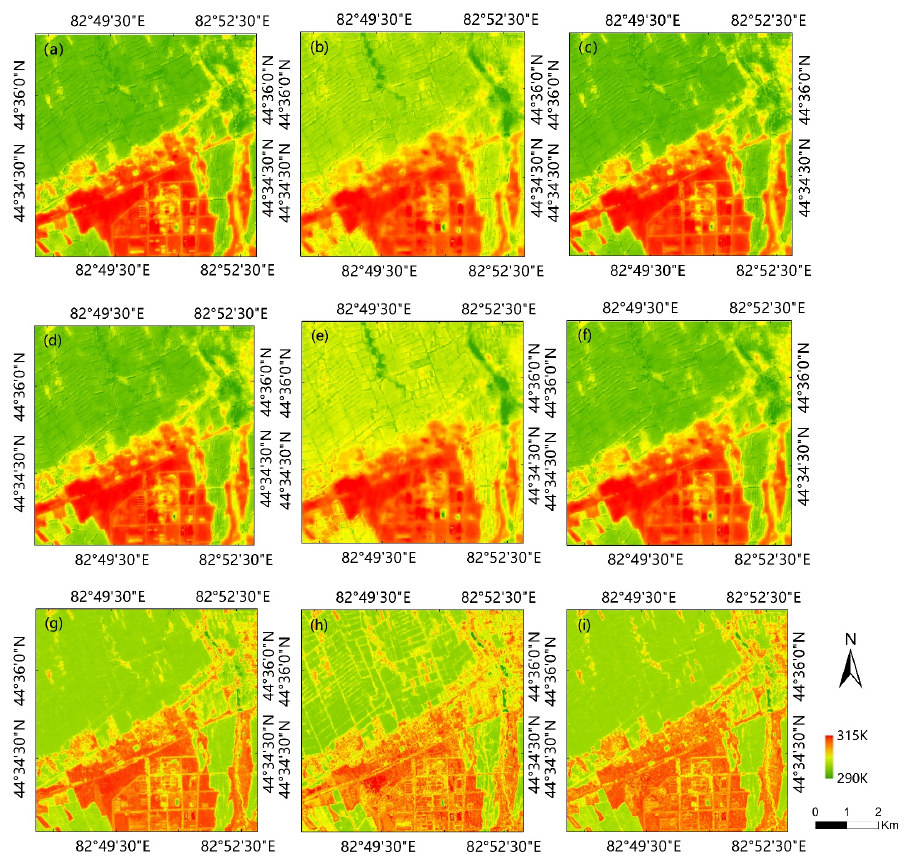
Figure 7. The 16 m downscaled LSTs obtained using three different methods with GF-6 images of 26 August 2019. ( a ) DisTrad LST GF 6_ Nir , ( b ) DisTrad LST RE 1 , ( c ) DisTrad LST RE 2 , ( d ) TsHARP LST GF 6_ Nir , ( e ) TsHARP LST RE 1 , ( f ) TsHARP LST RE 2 , ( g ) MIRF LST GF 6_ Nir , ( h ) MIRF LST RE 2 , ( i ) MIRF LST RE 2